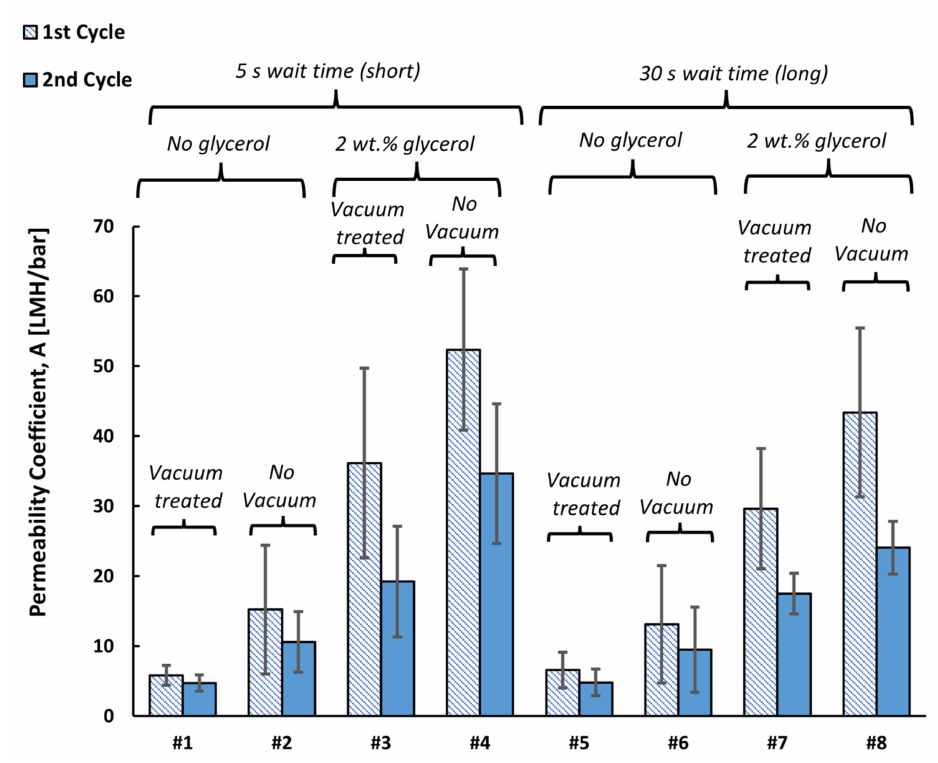
Figure 2. Average permeability coefficients of 10% PVDF- g -EGMP membranes prepared with various casting conditions. Error bars represent ± 1 σ for five separate sample